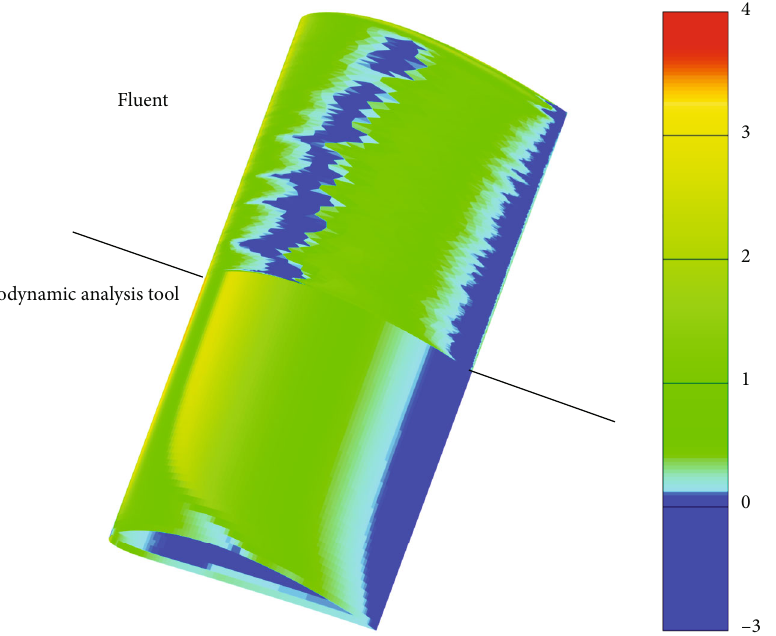
Figure 7: x -wall shear stress contours of the aerodynamic analysis tool and ANSYS-Fluent for 10 ° .